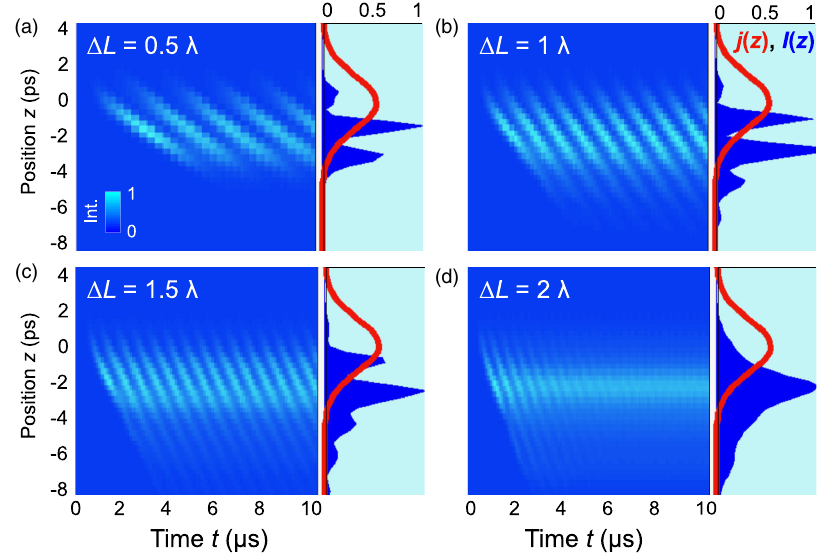
FIG. 9. Simulations of the optical pulse structure based on 4D Maxwell-Lorentz theory for different cavity detunings Δ L . The two- dimensional plots (a) – (d) show the evolution of the normalized FEL micropulse intensity shape I ð z Þ as function of the time t within the macropulse. Line graphs on the right present the optical pulse profile (blue) and electron bunch density j ð z Þ (red line) at the end of macropulse and undulator. The train of equally spaced subpulses is clearly reproduced. At the larger detuning value, a single-peaked asymmetric micropulse emerges. The ratio of the optical peak intensity evolves as 15 ∶ 5 ∶ 3 ∶ 1 from Δ L ¼ 0 . 5 λ to 2 λ